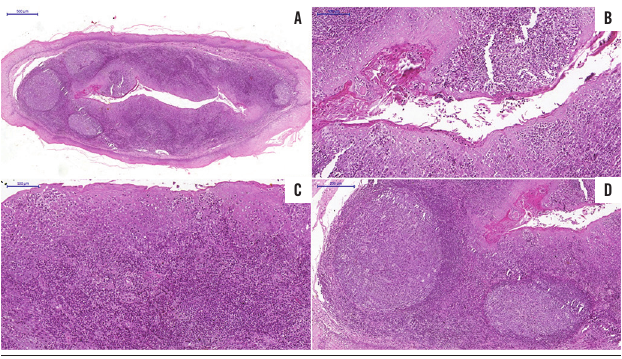
A) 500 µm: pathological cavity lined by epithelium and dense fibrous connective tissue capsule with lymphoid tissue completely circumscribing the lining epithelium;